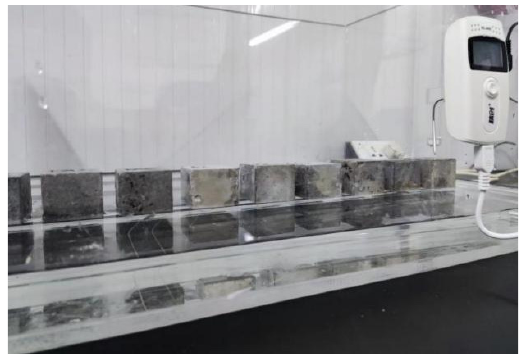
Figure 2. Capillary water absorption test device figure.